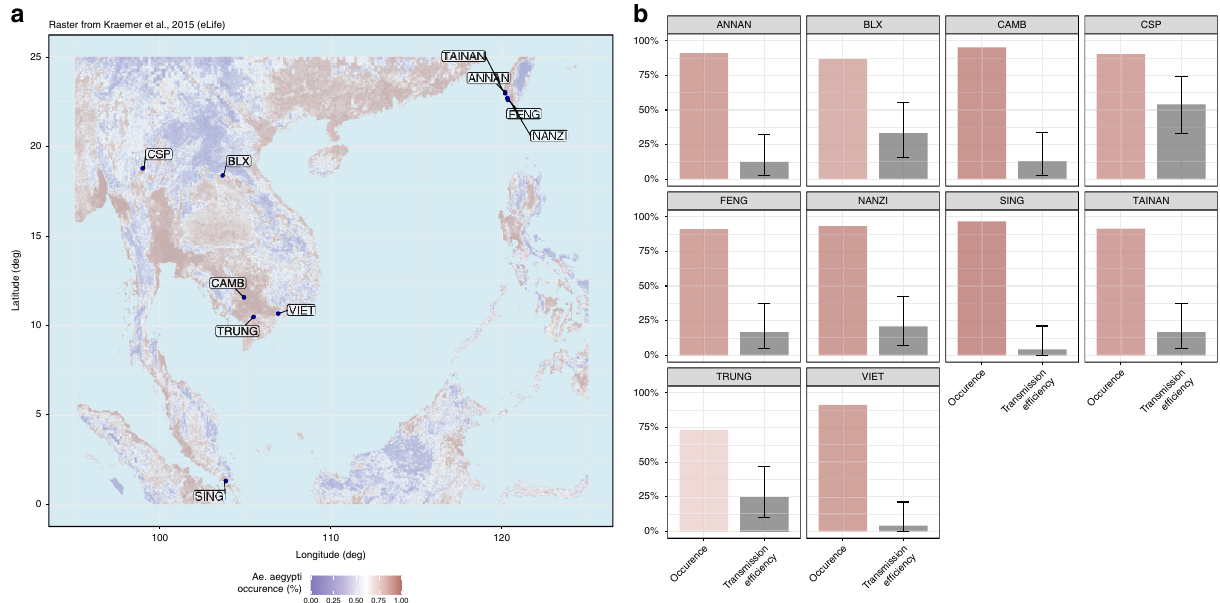
Fig. 5 Risk of Aedes aegypti -mediated YFV transmission in Asia. a Original data from Kraemer et al. showing the probability of encountering Aedes aegypti in South-East Asia. The colors correspond to probabilities: lower (blue) or higher (red) than the median probability across the whole map (white). b Modeled vector occurrence (colored bars matching the values from the scale in a ) along with mosquito transmission ef fi ciency (gray bar) of Aedes aegypti populations tested in laboratory conditions shown in a . This map uses data published by Kraemer et al. and was generated with R v4.0.1 (package raster v3.1-5). Source data are provided in Supplementary Data 1 fi le 28